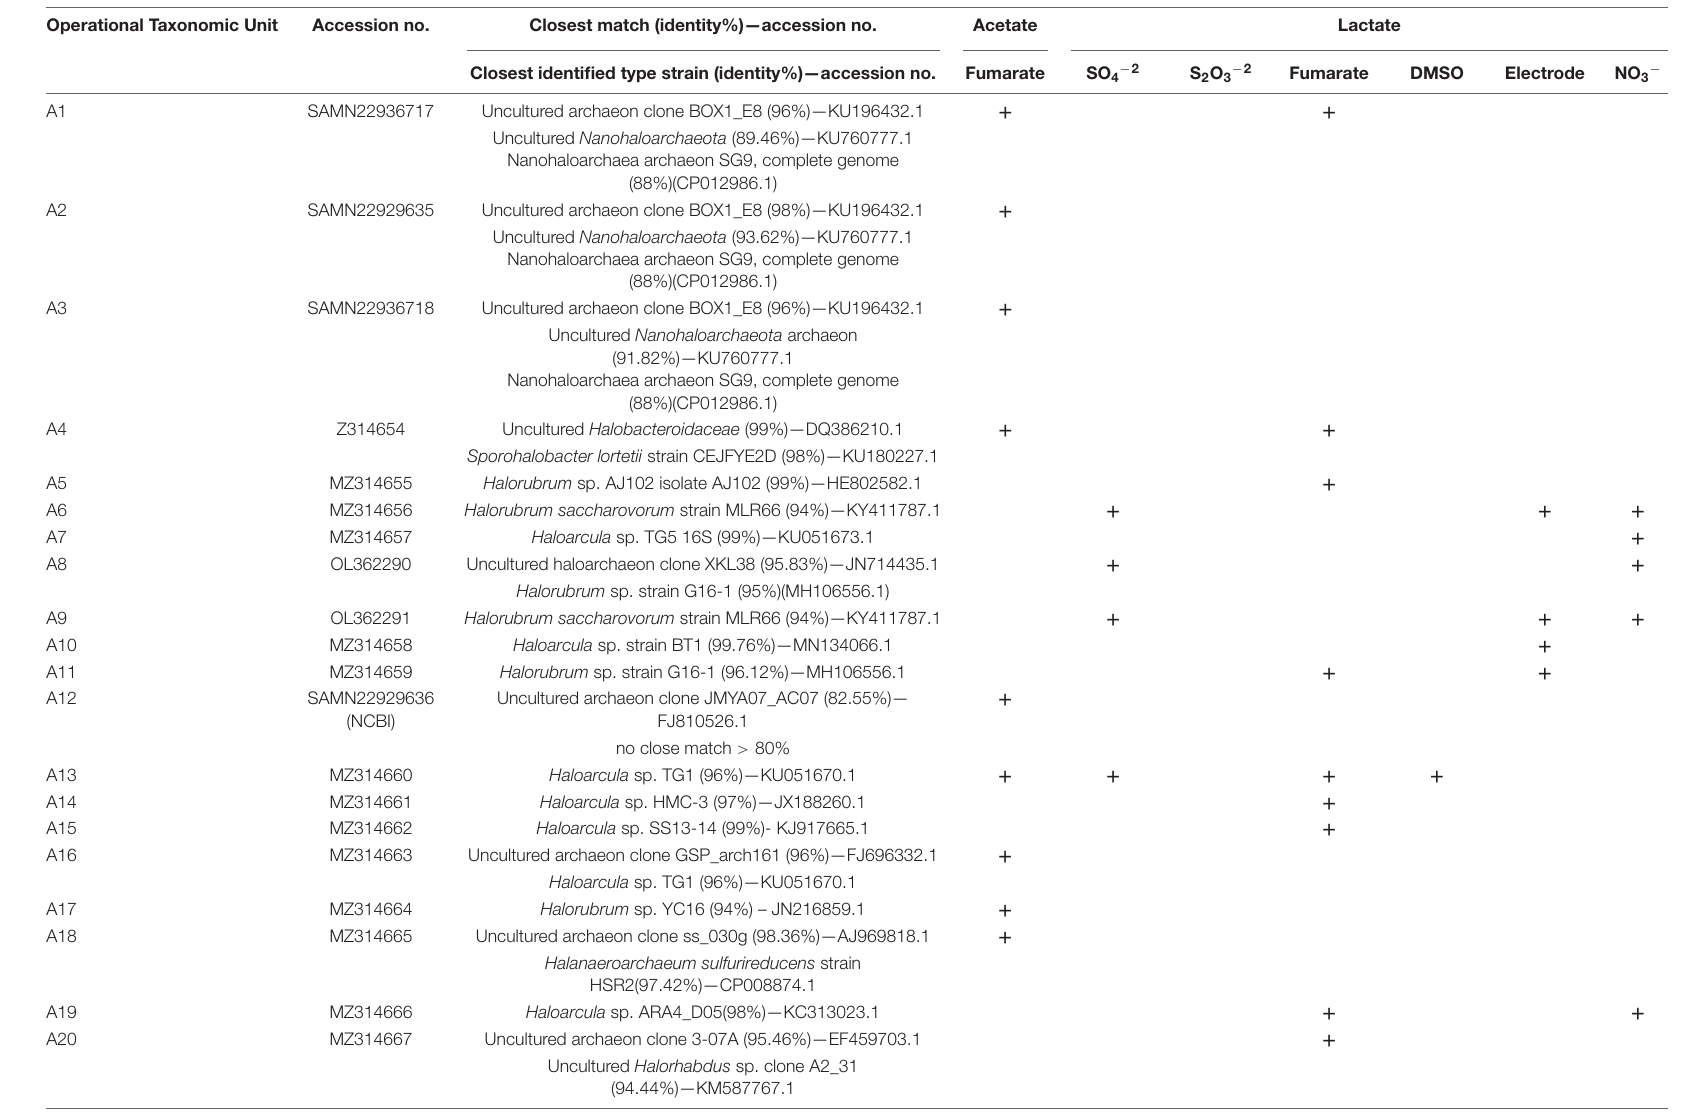
TABLE 3A | 16S rRNA gene sequences detected in cultures developed on acetate or lactate as the electron donor and the indicated electron acceptors upon amplification, DGGE separation, reamplification, and sequencing of archaeal DNA. Operational Taxonomic